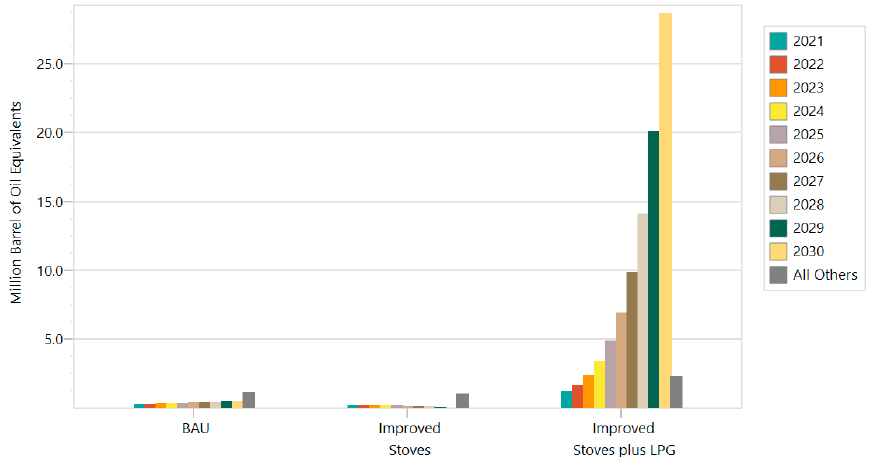
Figure 17. Comparison of the different scenarios in the LPG consumption for the stoves plus LPG scenario. Period 2021–2030. Electrified urban residential area.